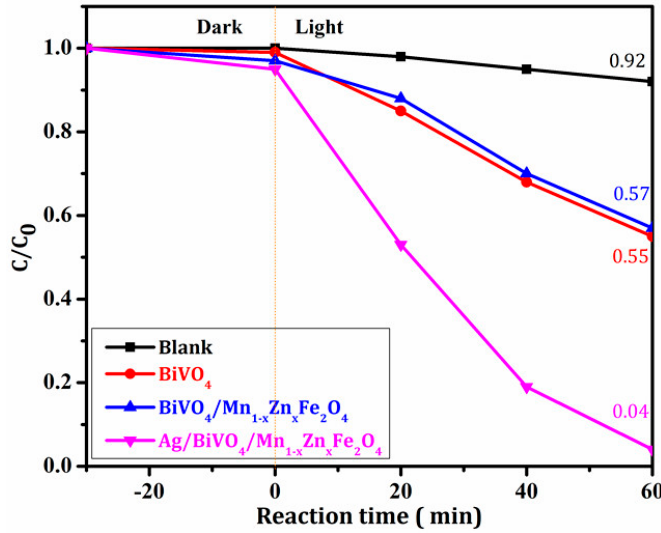
Figure 7. The degradation rates of RhB with the three photocatalysts.